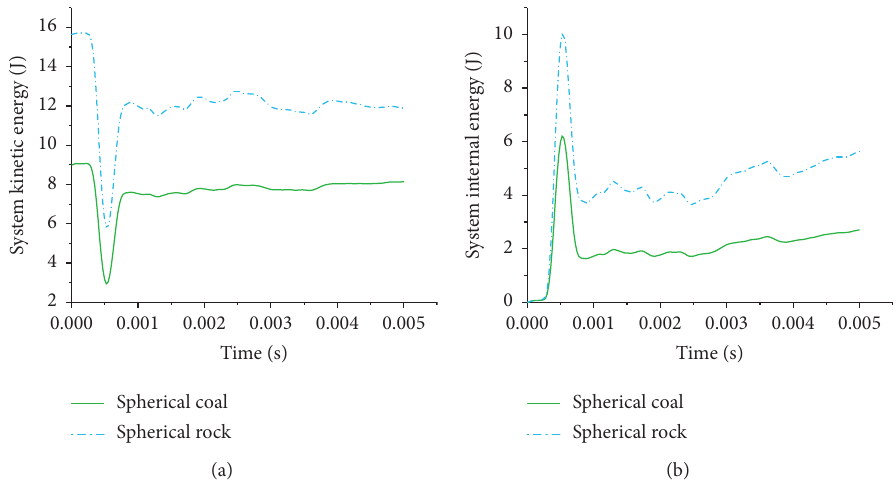
Figure 6: (a) System kinetic energy and (b) system internal energy under the impact of coal-rock particles.